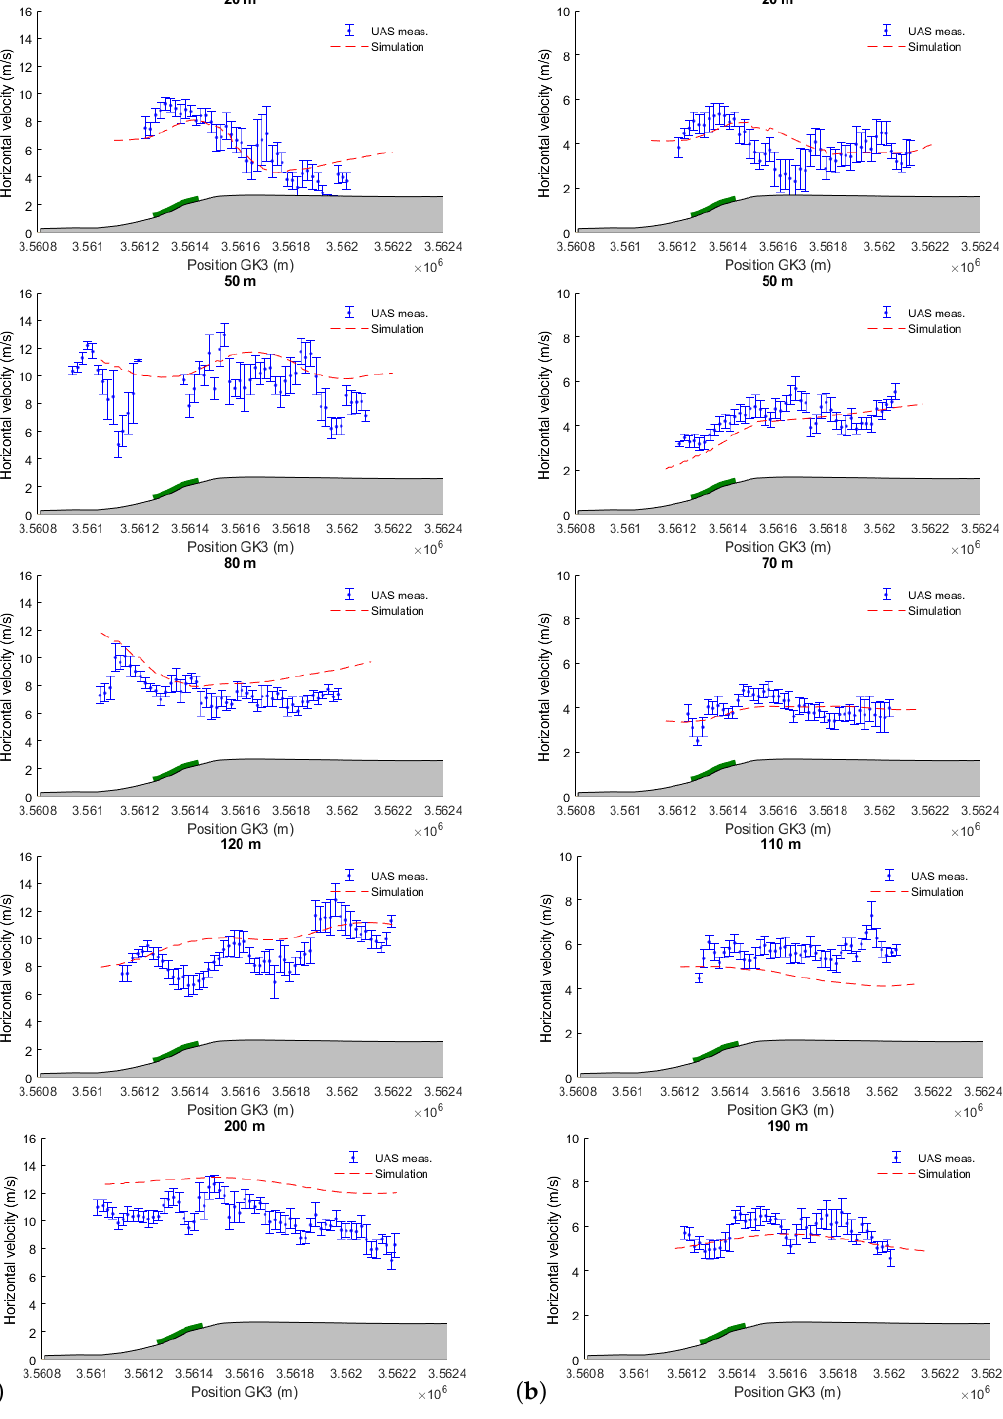
Figure 8. Horizontal velocity on 21 ( a ) and 22 ( b ) September at different altitudes along the UAS’s flight path. The blue dots are the UAS measurements and the red dashed lines are the simulation results. Error bars, corresponding to one standard deviation, are inserted for the MASC measurements. The green block represents the modelled